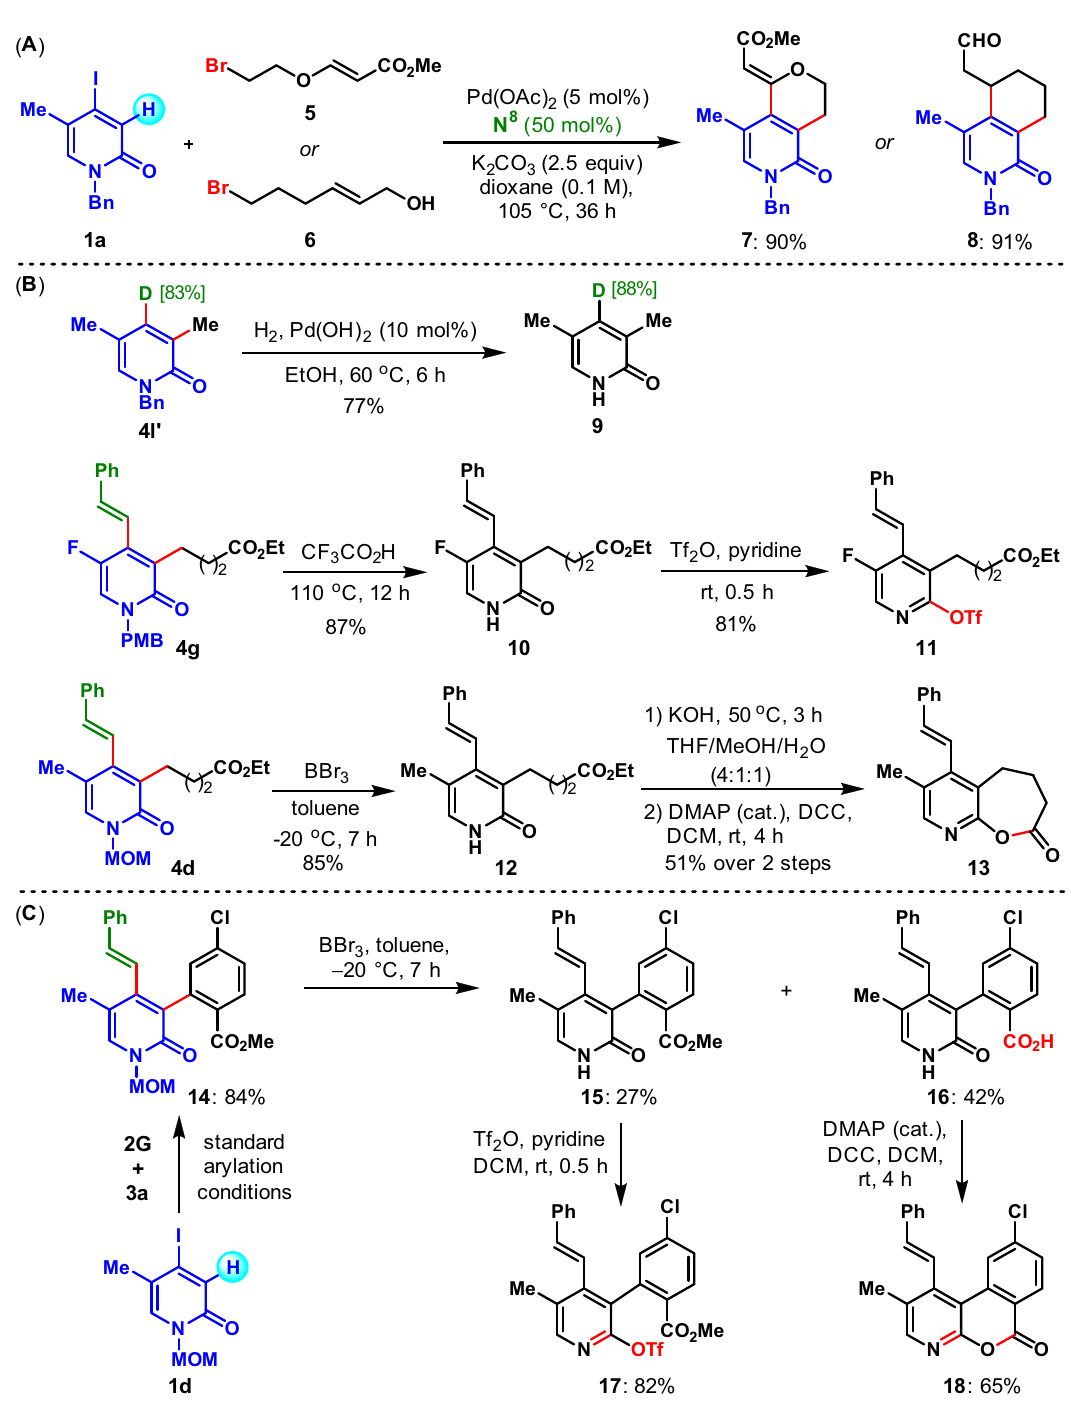
Fig. 3 Two-component annulation, N -deprotection and follow-up transformations of the obtained 2-pyridones. A Two-component annulation. B N - deprotection and follow-up transformations of the obtained 2-pyridones 4l ′ , 4g , and 4d . C N -deprotection and follow-up transformations of the obtained 2- pyridone 14